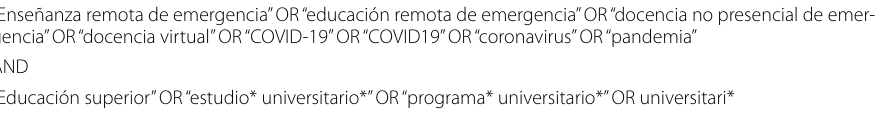
Table 2 Search string, Spanish language